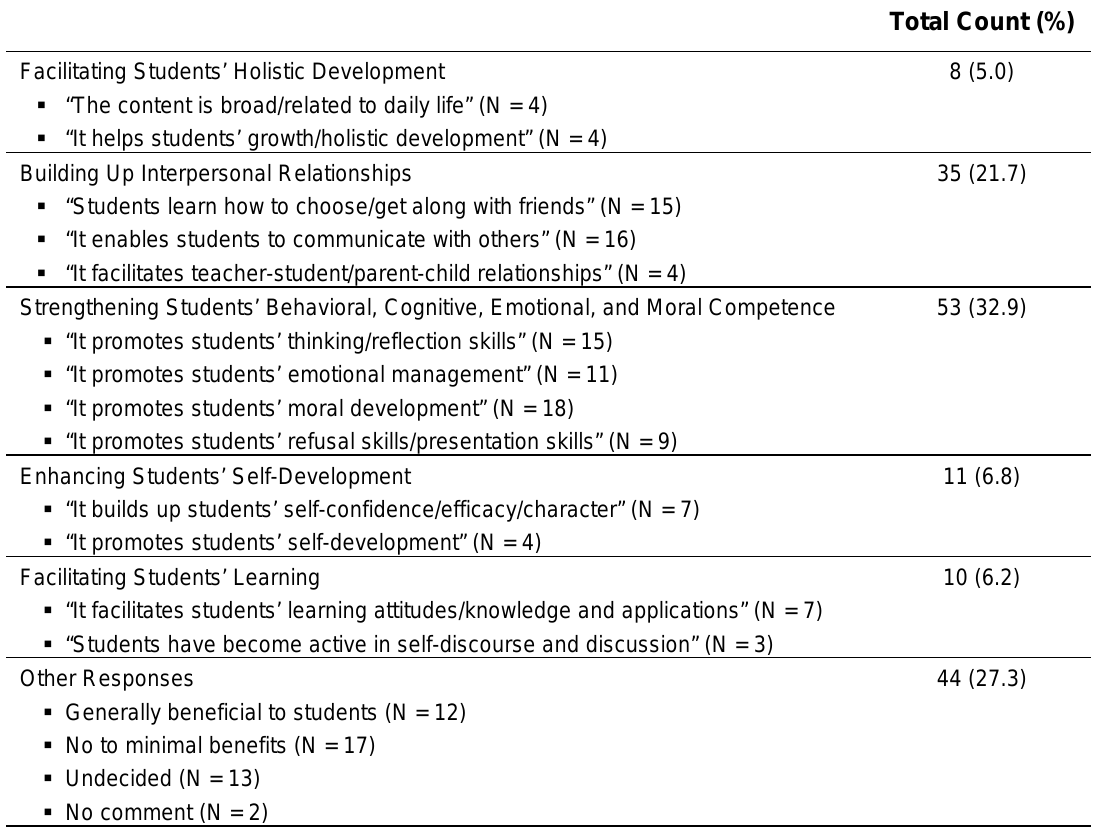
Workers’ Perceptions of the Benefits of the Secondary 1